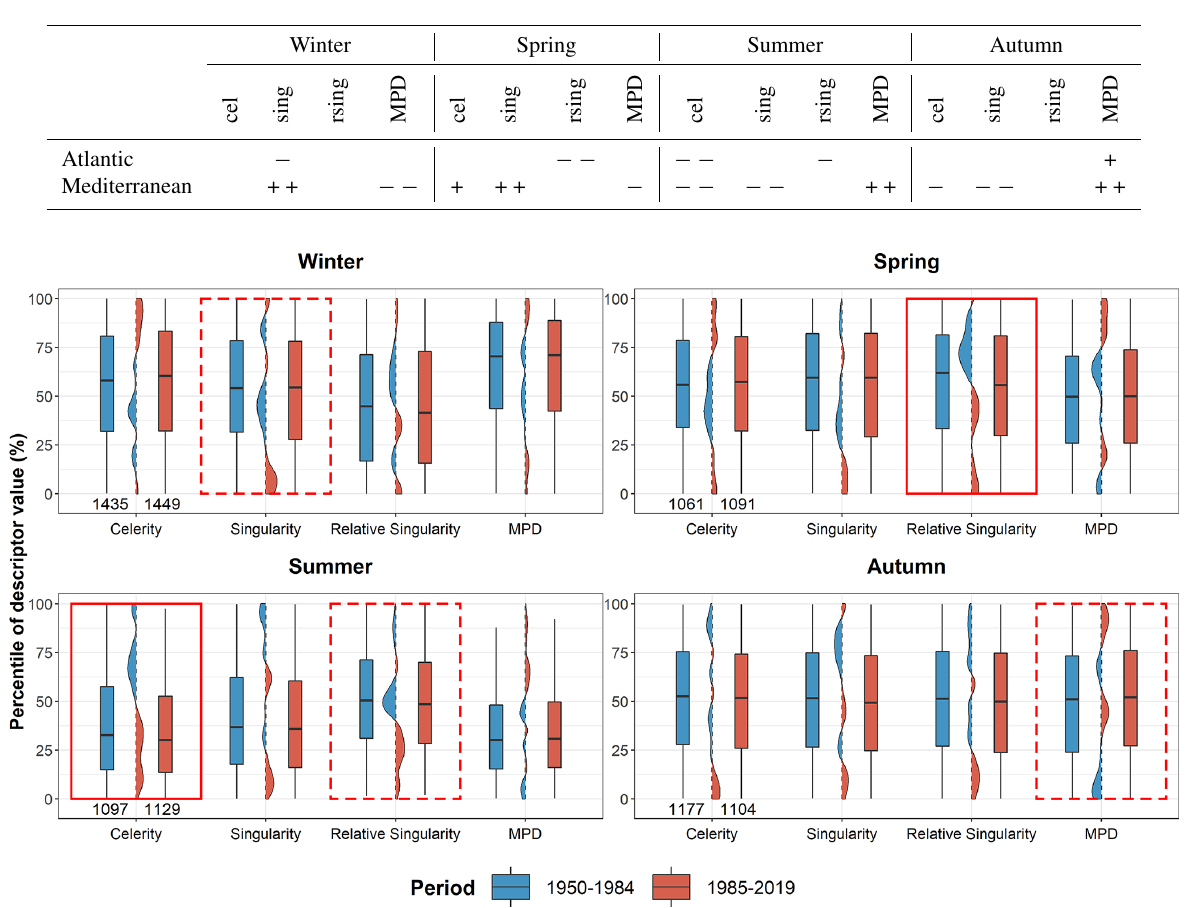
Figure 6. Boxplot of the daily celerity, singularity, relative singularity and MPD of Atlantic circulations for the two 35-year periods of 1950– 1984 and 1985–2019, per season. Descriptor values are represented as percentiles to allow for the representation of the four descriptors on the same axis. Percentiles are computed with respect to all days of 1950–2019 belonging to the Atlantic influence. The difference in density between the two sub-periods is shown between the boxplots. The range of the density that is colored in blue (red) means that the considered descriptor shows more values within this range in the early (present) period. The numbers in the bottom left of the graphs indicate the number of days considered in the early and present periods. A continuous red rectangle indicates the descriptor and season for which the difference in distribution between the two sub-periods is significant according to both the Kolmogorov–Smirnov test and the Anderson–Darling test. A dashed red rectangle indicates significance with only one of the two tests. The difference is considered significant if the p value of the test is lower than